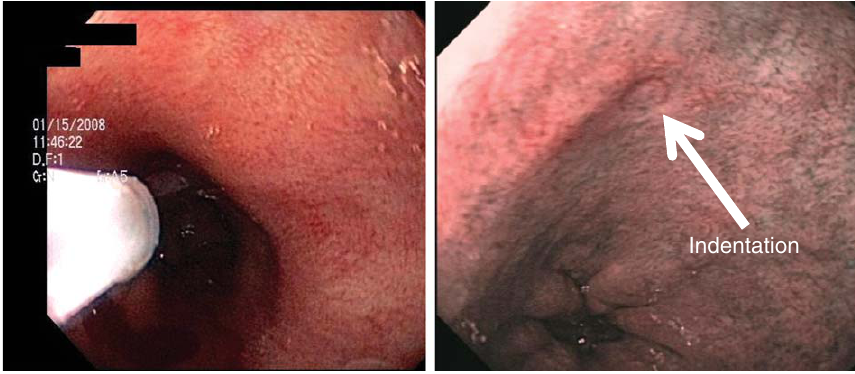
Fig. 5. (Left) Application of fiber optic a/LCI probe during endoscopic examination of the esophageal lumen. (Right) temporary indentation left by a/LCI probe under narrow band illumination. Adapted from Ref.